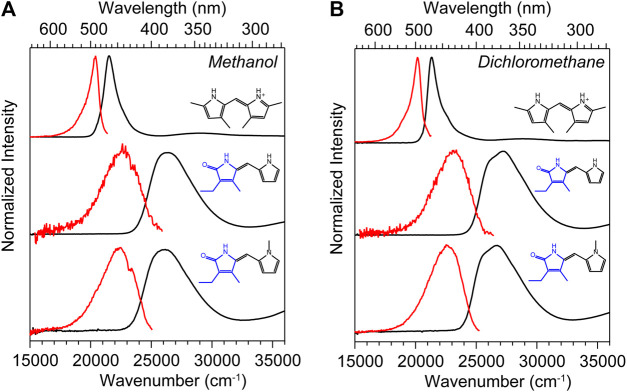
UV-vis absorption (black) and corrected fluorescence (red) spectra for DPY, DPN, and N-Me-DPN in (A) methanol and (B) dichloromethane.